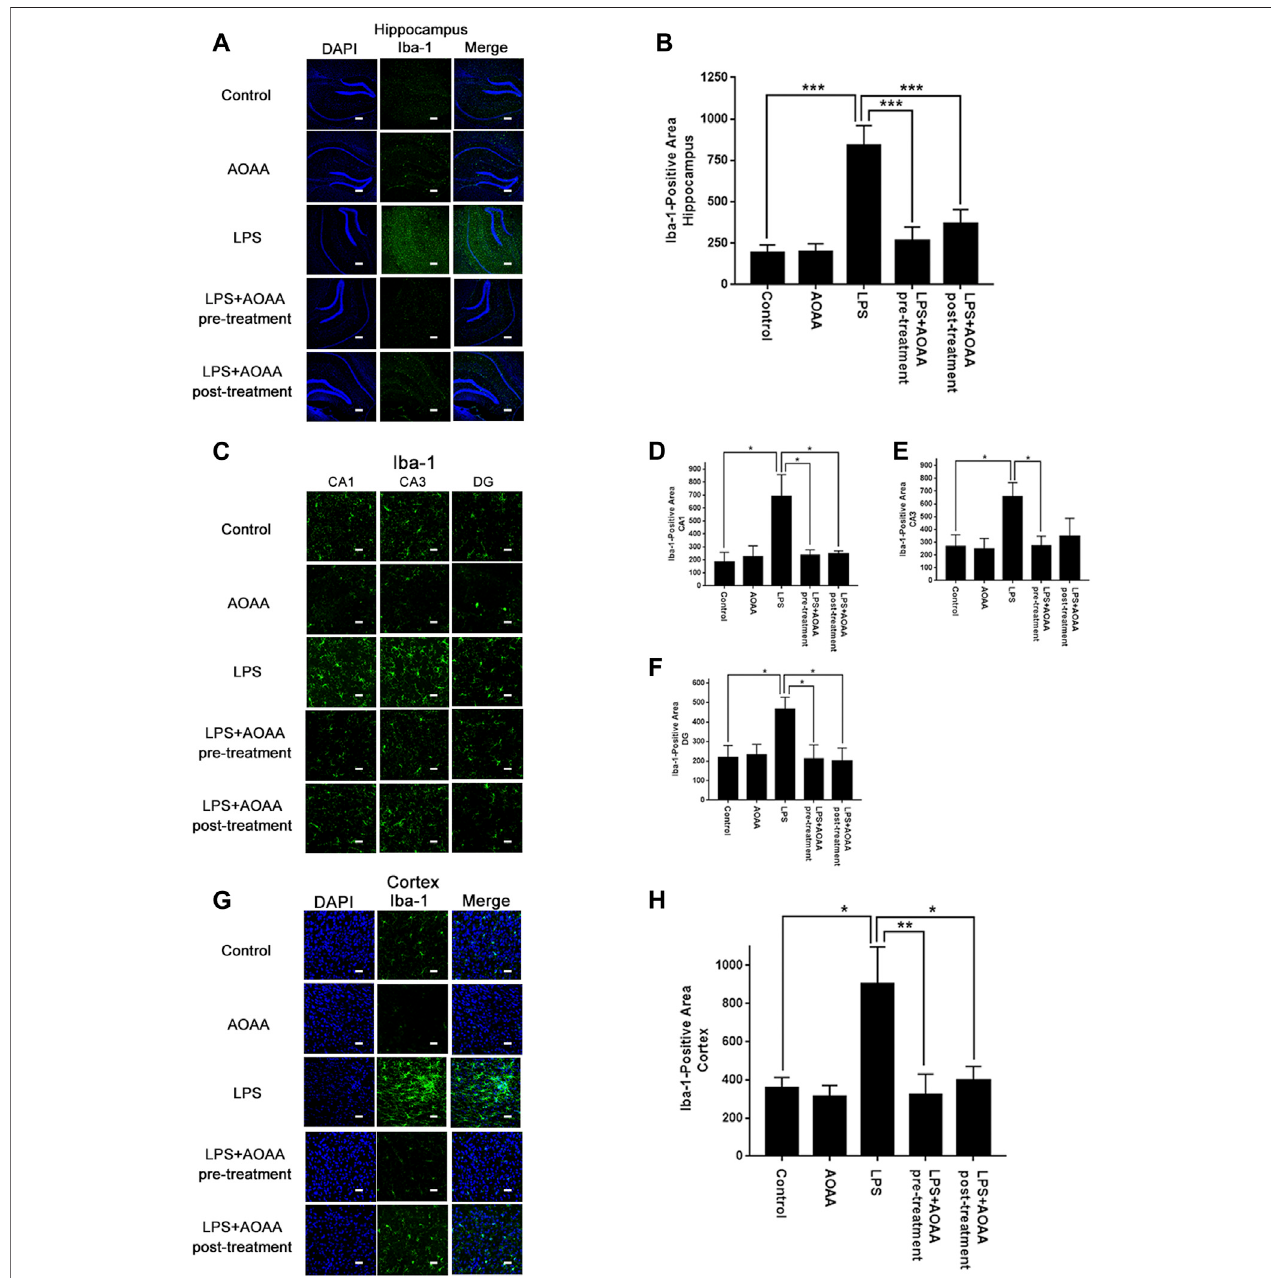
FIGURE1| BothAOAApre-treatmentandpost-treatmentattenuatedLPS-inducedIba-1increasesinthehippocampusandthecerebralcortexofC57BL/6mice. (A) Theimmuno fl uorescence stainingassayshowedthatboth pre-treatmentandpost-treatmentofAOAAdecreasedLPS-inducedIba-1increasesinthe hippocampus of the mice. Scale bar (cid:2) 100 μ m. (B) Quanti fi cations of the images indicated that both pre-treatment and post-treatment of AOAA signi fi cantly decreased LPS-induced Iba-1 increases in the hippocampus of the mice. (C) The immuno fl uorescence staining assay showed that both pre-treatment and post-treatment of AOAA decreasedLPS-inducedIba-1increasesinthehippocampalCA1,CA3,DGareasofthemice.Scalebar (cid:2) 20 μ m. (D – F) Quanti fi cationsoftheimagesindicatedthatboth pre-treatment and post-treatment of AOAA signi fi cantly decreased LPS-induced Iba-1 increases in the hippocampal CA1, CA3, DG areas of the mice. (G) The immuno fl uorescence staining assay showed that both pre-treatment and post-treatment of AOAA decreased LPS-induced Iba-1 increases in the cerebral cortex of the mice. Scale bar (cid:2) 20 μ m. (H) Quanti fi cations of the images indicated that both pre-treatment and post-treatment of AOAA signi fi cantly decreased LPS-induced Iba-1 increasesinthecerebralcortexofthemice.ThemicewereadministeredwithLPS(250 μ g/kg,i.p,).AOAAwasadministered 3 daysbeforeLPSadministrationor3 days afterLPSadministration. 7 daysaftertheLPSadministration, immuno fl uorescencestainingassayswereconducted.Foreach animal,threeslicesofthebrainwereused for the analyses. The mean of the data from analyses of the three slides was used for statistical analysis. N (cid:2) 5. *, p < 0.05, ***, p < 0.001.